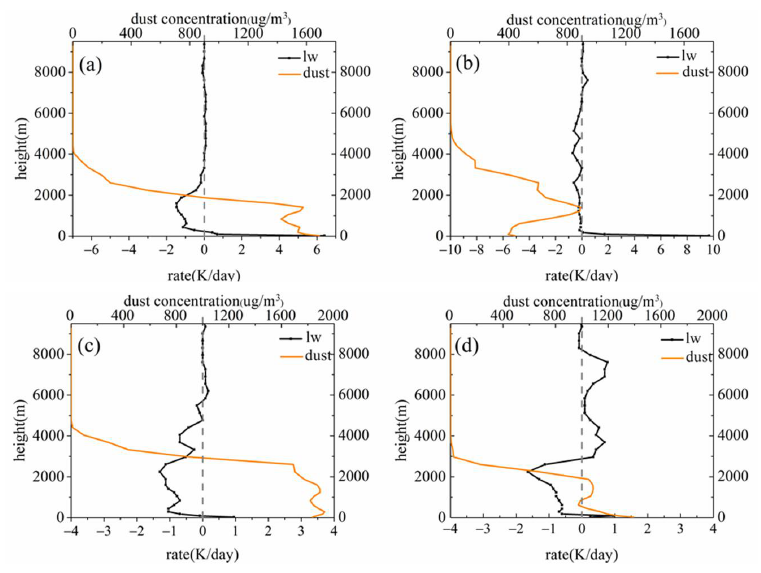
Figure 11. Vertical profiles of the dust concentration (orange lines) and dust-induced changes of the atmospheric LW radiative heating profiles in K day −1 (black lines) at the ( a ) HT, ( b ) KEL, ( c ) KSH, atmospheric LW radiative heating profiles in K day − 1 (black lines) at the ( a ) HT, ( b ) KEL, ( c ) KSH, and ( d ) TZH stations in the TB on 29 April 2015, at 18:00 UTC. and ( d ) TZH stations in the TB on 29 April 2015, at 18:00